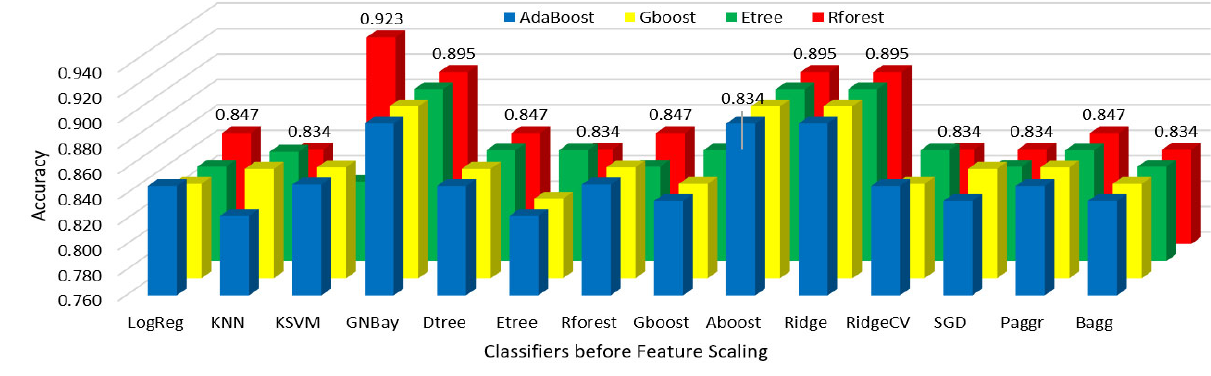
Figure 7. Regressor feature importance performance of all classifiers before scaling.